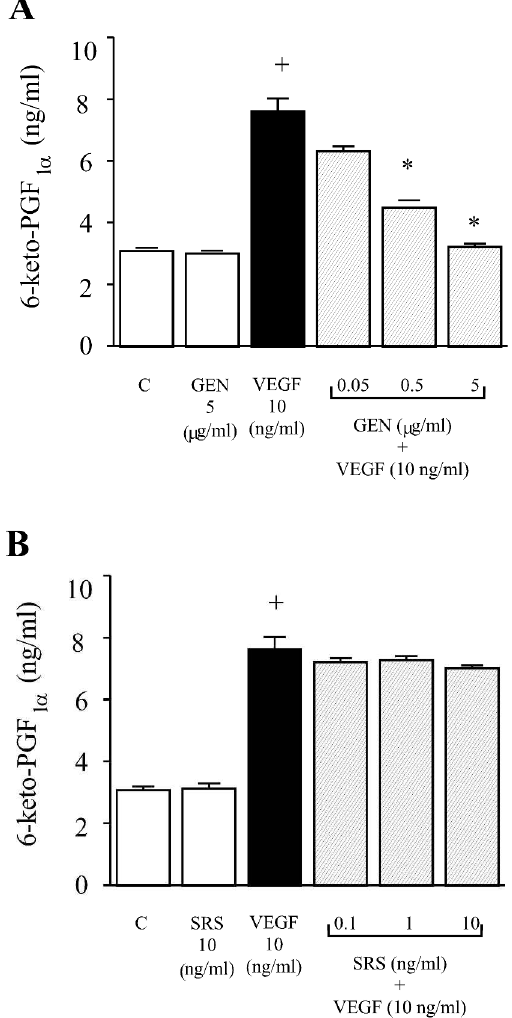
FIG. 4. The effects of (A) genistein (GEN) (0.05–5 m g/ml) and (B) staurosporine (SRS) (0.1–10ng/ml) on COX activity in HUVEC treated with VEGF (10ng/ml) for 24h. COX activity was measured by the formation of 6-keto-PGF 1 a in the presence of exogenous arachidonic acid (10 m M, 10min). Data are expressed as mean ± standard error of the mean of 12 determinations from at least four separate experimental days. * p < 0.05 when compared with VEGF-treated HUVEC at 24h; + p < 0.05 when compared with untreated HUVEC at 24h (C).